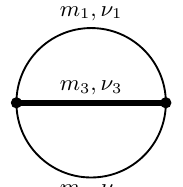
Figure 1 . The main object of the paper, the massive two-loop vacuum integral as defined in eq. (1.5). In our graphical representation, each line corresponds to a massive scalar propagator 1 / [ m 2 + p 2 ] ν , with respective mass and power as indicated. We use a thick line to mark the special propagator mass m 3 = m 1 + m 2